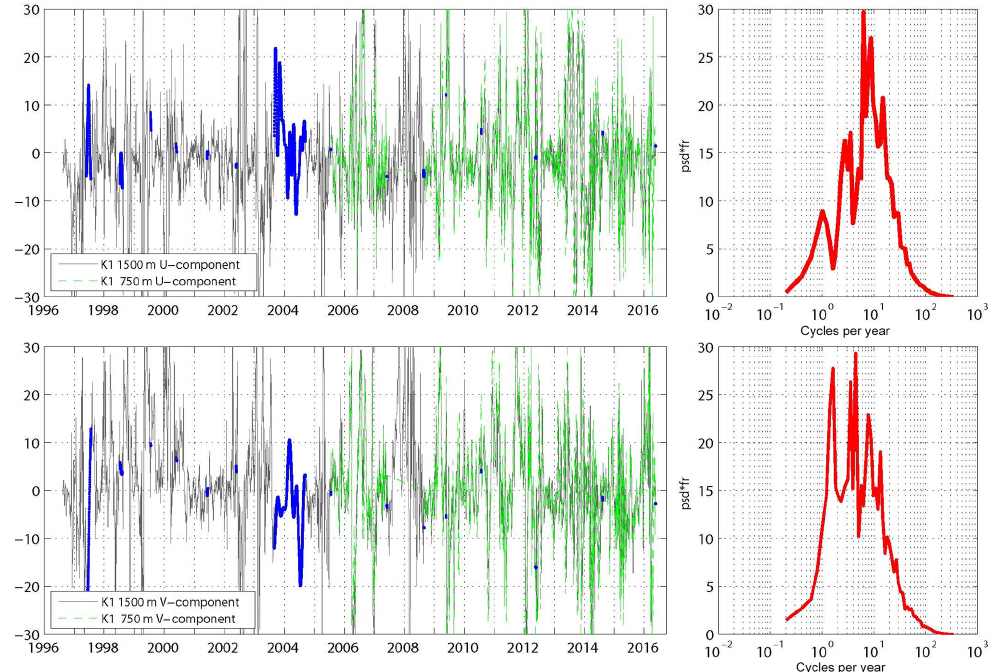
Figure 7. Example of a current time series from the central Labrador Sea at mooring K1. Two depth levels were occupied regularly (750m since 2006, green curve; 1500m since 1996). Gaps (blue lines) are filled by interpolation based on empirical orthogonal functions (Zantopp et al., 2017). High-frequency spectra from 1500m records (right